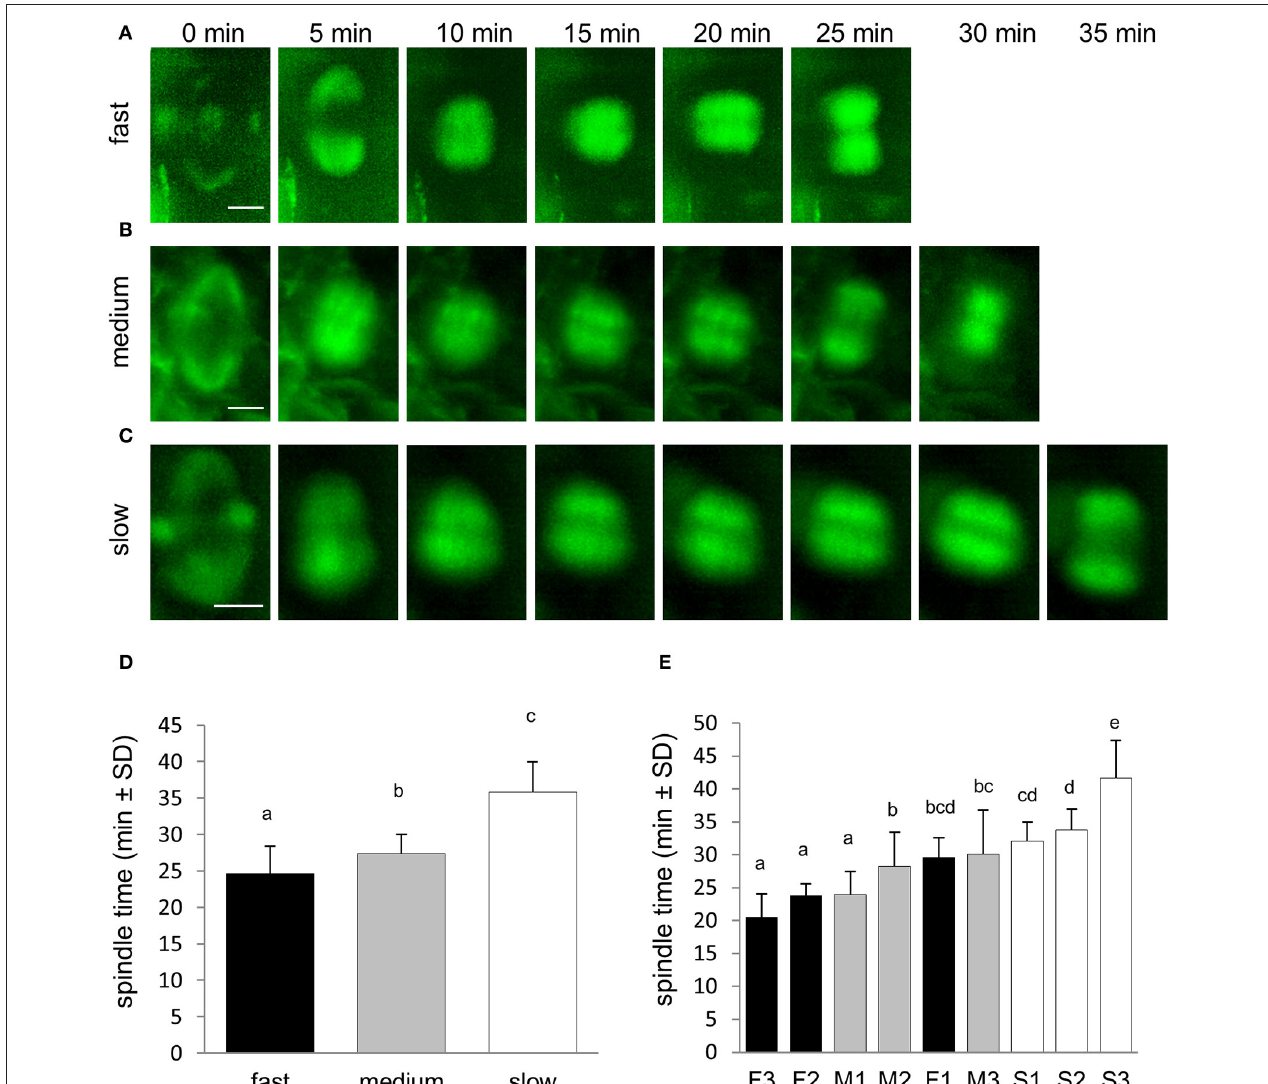
FIGURE 4 | Duration of the mitotic spindle stage from prometaphase to telophase during the cell division. (A–C) Series of stills from time-lapse light-sheet imaging of dividing cells in root epidermis and cortex of M. sativa plants expressing 35S::GFP:MBD construct. Sequence of prometaphase, metaphase, anaphase and telophase stages starting from PPB disappearance and mitotic spindle formation at prometaphase and finishing by last stage of mitotic spindle presence at telophase. Progress of the mitotic spindle stages is shown for fast-growing roots (A) , medium-growing roots (B) , and slow-growing roots (C) . Series of images were recorded in 5min intervals from the PPB disappearance and mitotic spindle formation at prometaphase (time 0min). (D) Average duration time of mitotic spindle (prometaphase, metaphase, anaphase, and telophase) stages of cell division in all roots of fast-growing, medium-growing and slow-growing group of roots. (E) Average duration time of mitotic spindle (prometaphase, metaphase, anaphase, and telophase) stages in all dividing cells of individual roots. Roots are arranged from shortest to longest average duration time of mitotic spindle. Black bars represent fast-growing roots (F1, F2, F3), gray bars represent medium-growing roots (M1, M2, M3) and white bars represent slow-growing roots (S1, S2, S3). Different letters above the bars represent statistical significance according to one-way ANOVA test at P < 0.05. Bars = 5 µ m (A–C)